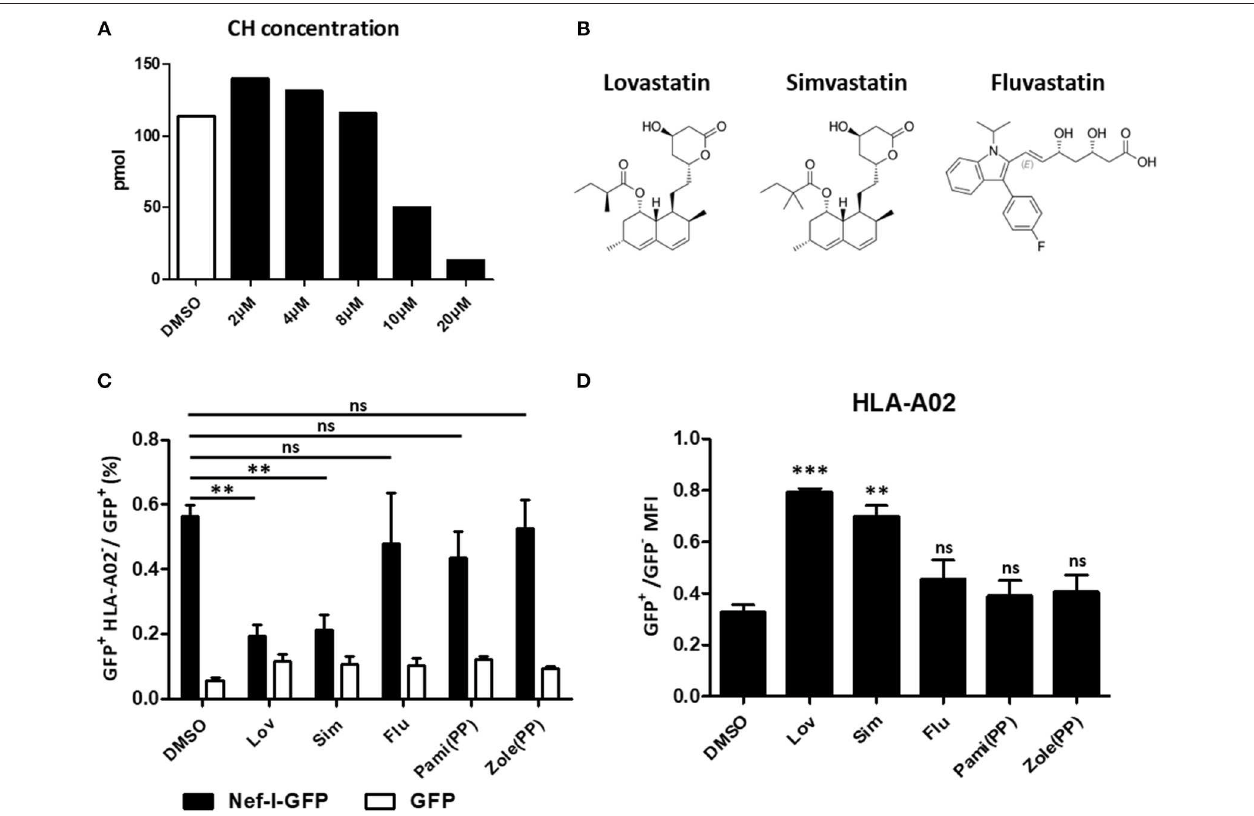
FIGURE 6 | Restoration of MHC-I by lovastatin is independent from mevalonate pathway. HEK293T cells were treated with lovastatin from 2 to 20 µ M. Forty-eight hours later, ELISA analysis the concentration of the cholesterol in the drug-treated cells (A) . Structures of lovastatin, simvastatin and fluvastatin (B) . Twelve hours after transfection of pcDNA3.1-Nef-IRES-GFP or pcDNA3.1-IRES-GFP (800 ng per well), HEK293T cells were treated with lovastatin, simvastatin, fluvastatin or bisphosphonates (zoledronic acid and pamidronate). Forty-eight hours after transfection, the ratios of GFP + MHC-I − to GFP + population were analyzed by flow cytometry and summarized with bar plot. Data show the means ± standard deviations in three independent experiments (C) . The ratios of MHC-I MFI on GFP + to GFP − cells from pcDNA3.1-Nef-IRES-GFP transfections was determined by flow cytometry. Data show the means ± standard deviations in three independent experiments (D) . P -values were calculated using the two tailed unpaired Student’s t -test with equal variances, n = 3. ** p < 0.01, *** p <